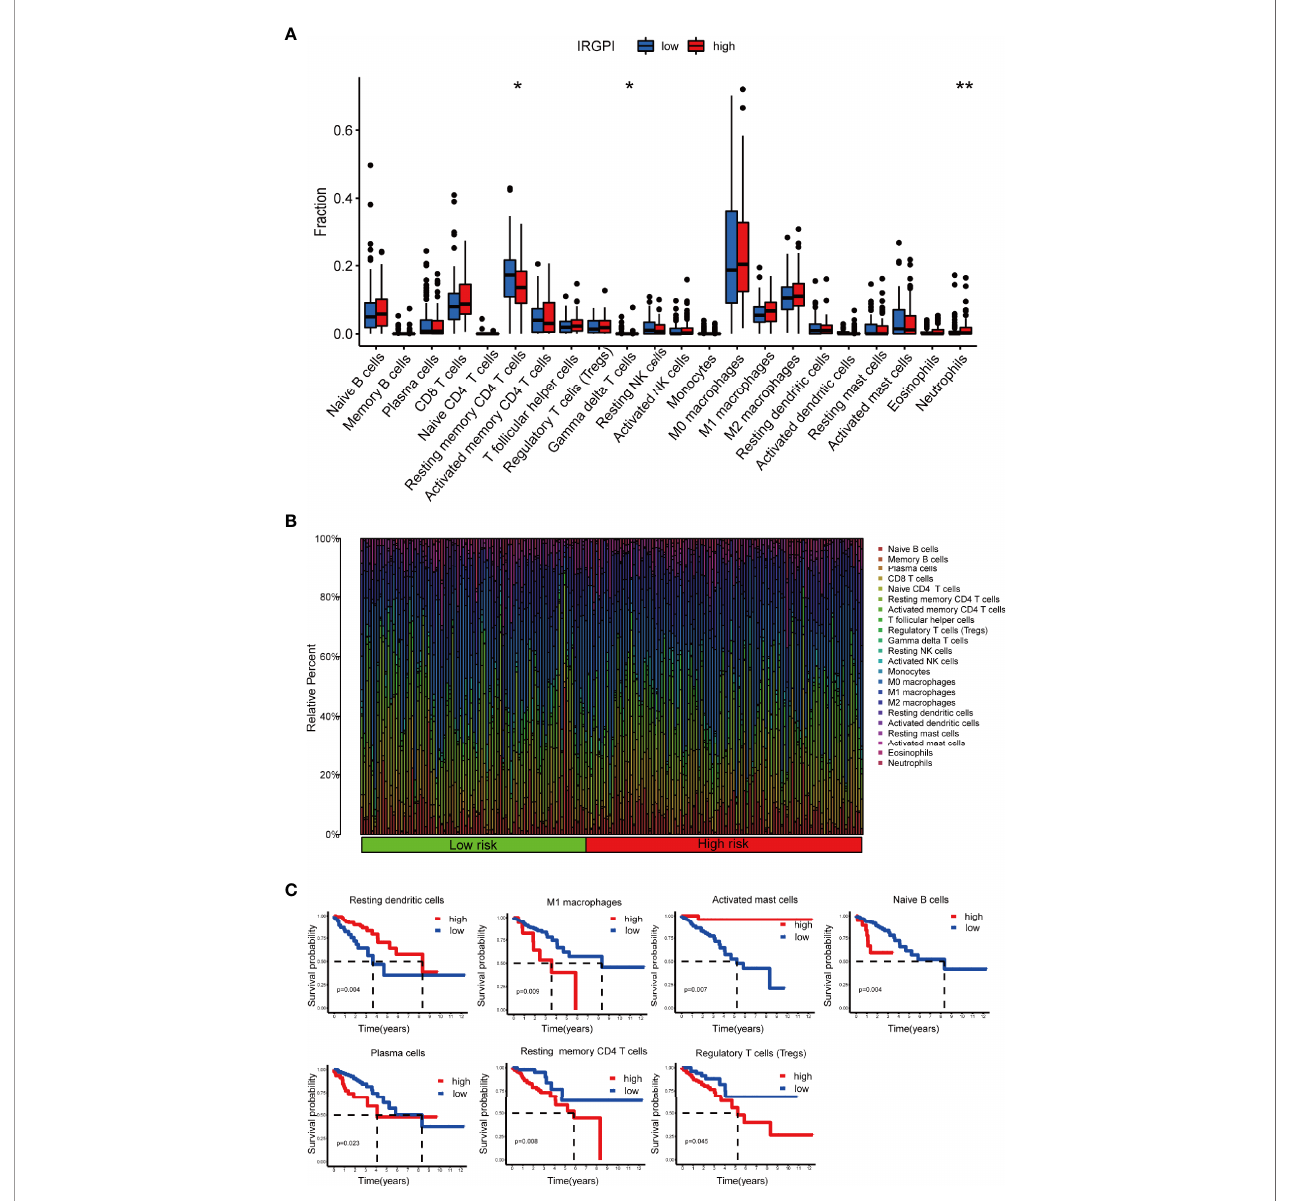
FIGURE 6 | TME landscape of colon cancer and characterization of different IRGPI groups. The proportions of TME cells in the high and low IRGPI groups. (A) The correlation of IRPGI scores with 22 immune cells. (B) Characteristics associated with the immune landscape. (C) Kaplan-Meier survival analysis of the correlation of immune cell abundance ratios in the IRGPI group. (* P < 0.05; ** P < 0.01). TME, tumor immune microenvironment; IRGPI, immune-related gene prognostic